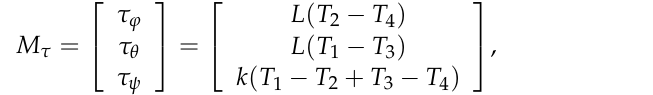
where I is the diagonal inertia matrix of the quadrotor, w = [ of the quadrotor, and M τ = [ τ ϕ , τ θ , τ ψ ] T is the control torque given by: